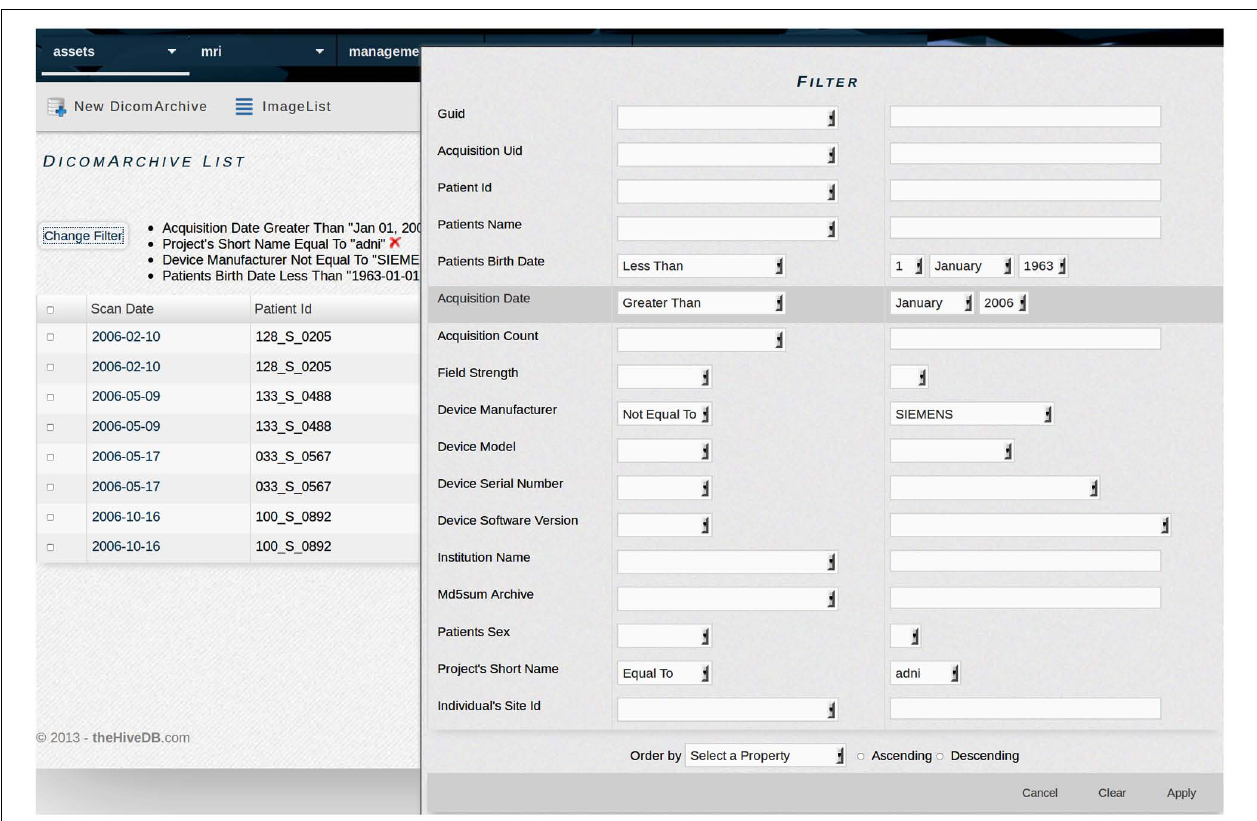
FIGURE 1 |TheHiveDB provides extensive filters for searching within entity lists (e.g., individuals or different types of assets). The example shows a filter used for searching ADNI DICOM archive data using specific criteria like data acquired for individuals born prior to 1963 and scanned after January 2006 on a non-Siemens